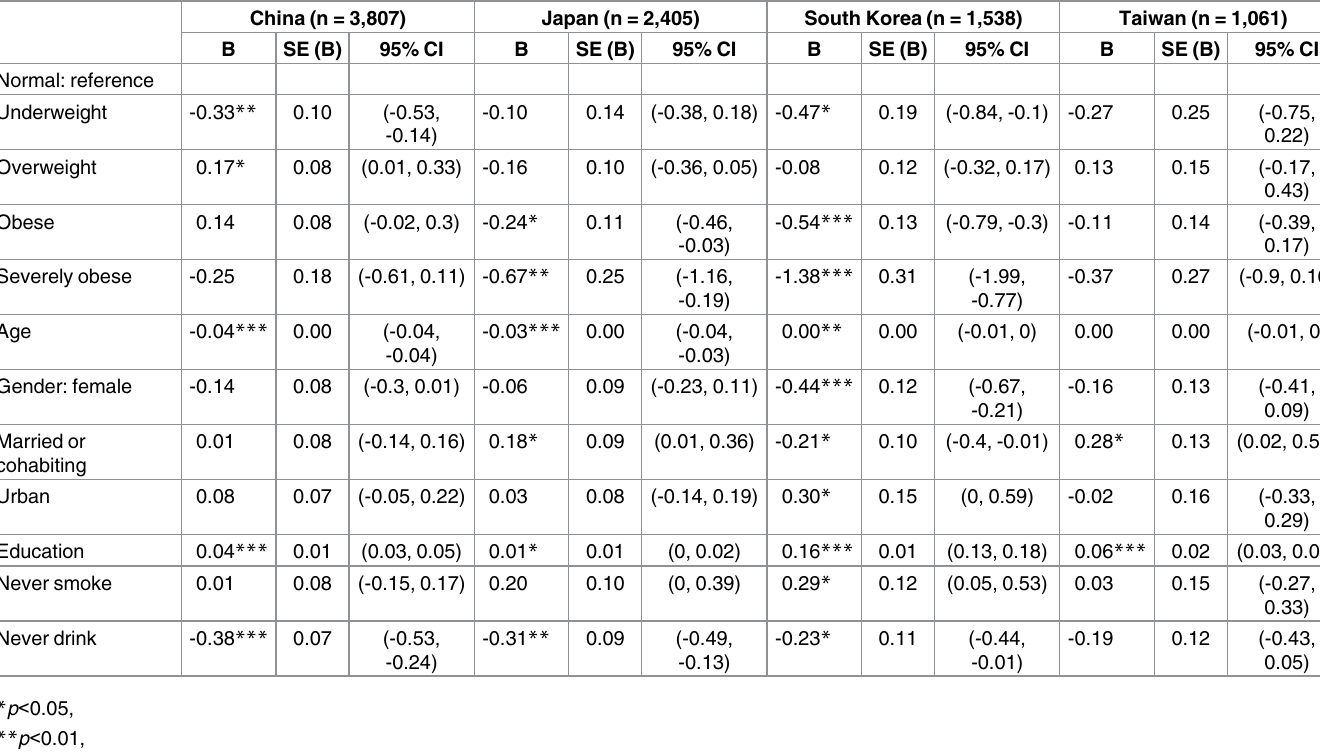
Table 3. Ordinal logit regression of self-rated health status on weight status and other covariates by